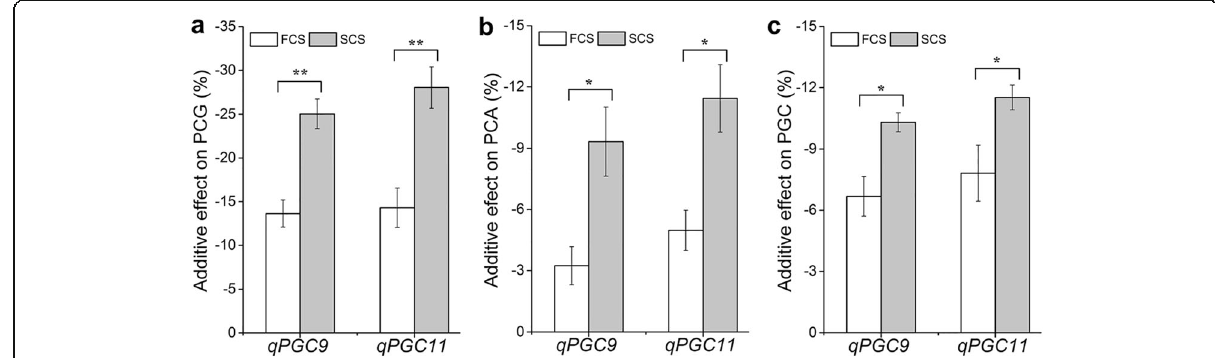
Fig. 6 The additive effects of qPGC9 and qPGC11 on grain chalkiness in first cropping seasons (FCS) and second cropping seasons (SCS). PCG percentage of chalky grain ( a ). PCA Percentage of chalky area ( b ). PGC Percentage of grain chalkiness ( c